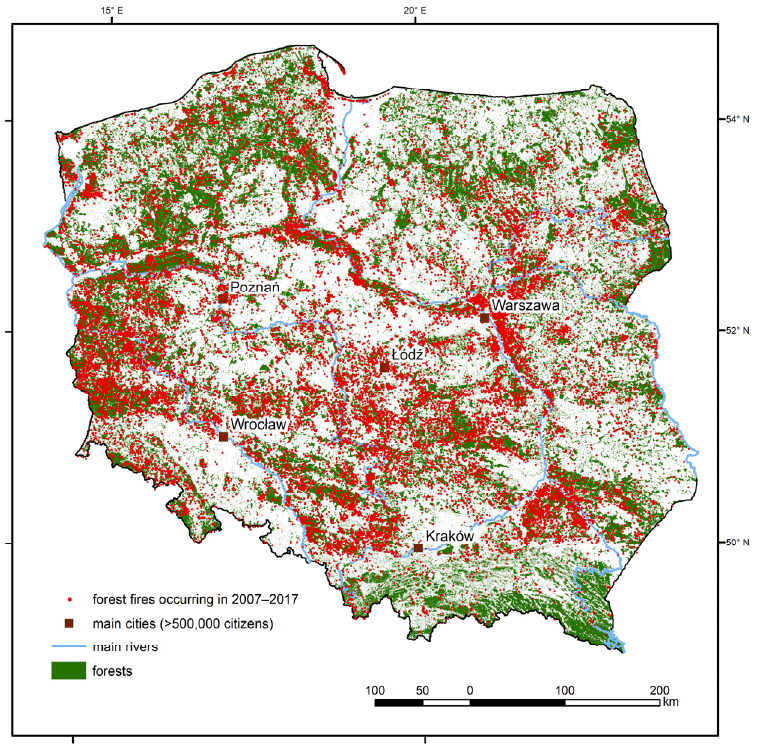
Figure 2. Study area: forest fires (2007–2017) in relation to selected elements of the geographical environment of Poland.